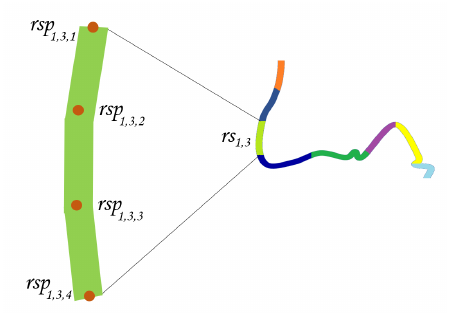
Figure 14 exemplifies the “sampling” operation of a segment.